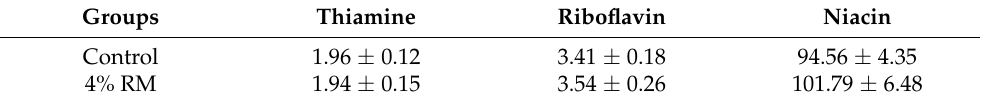
Table 4. Vitamin content of the P. ostreatus mycelium grown on PDA (mg/100 g, dry weight basis).